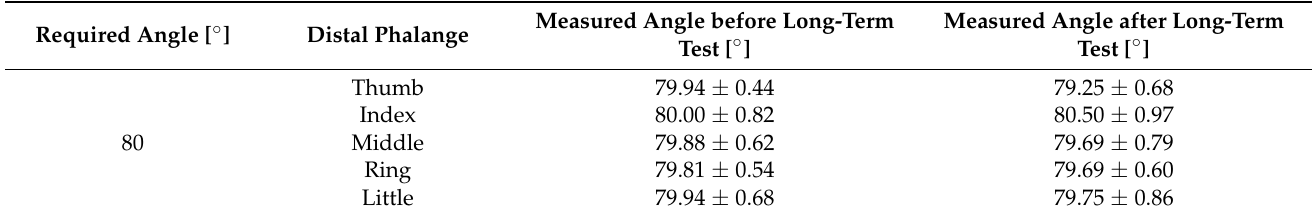
Table 4. Verification of distal phalange measured at an angle of 80 ◦ before and after the long-term test. Required Angle [ ◦